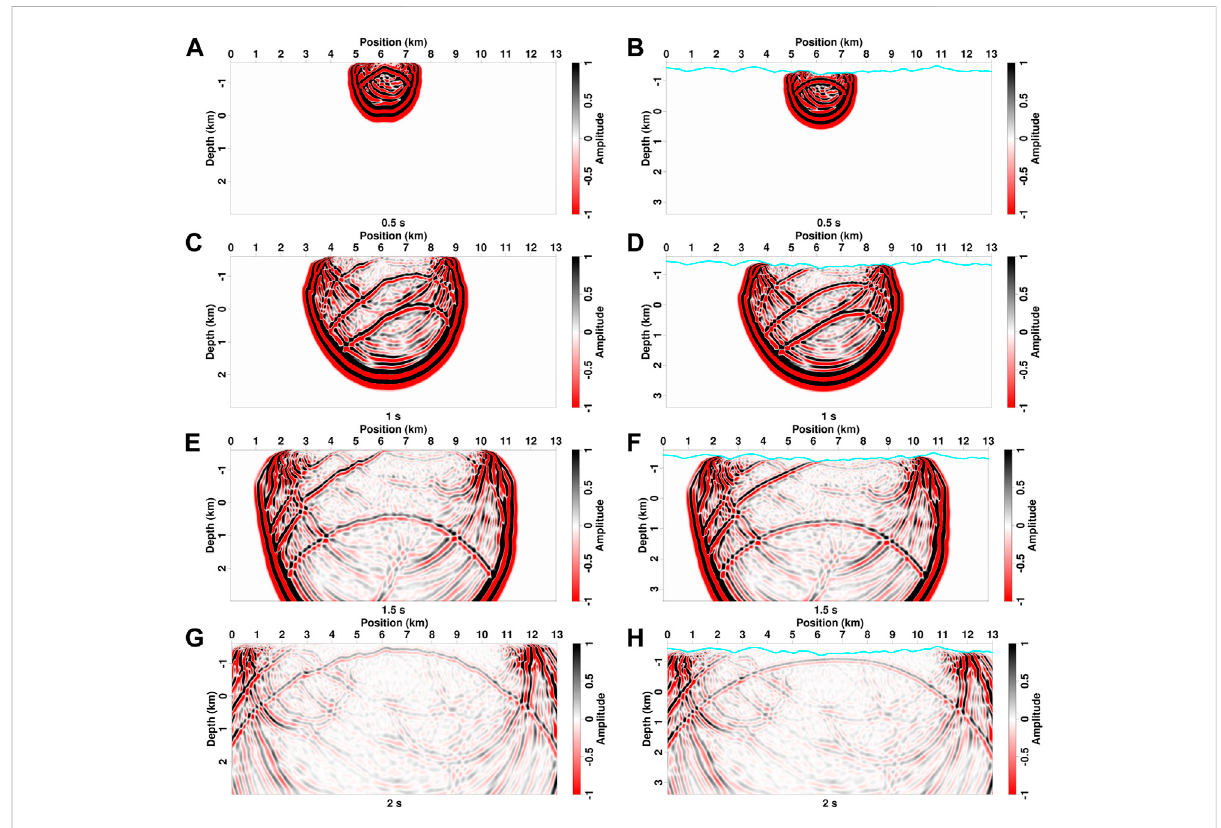
FIGURE 11 (A – H) Viscoacoustic wave fi elds of 2D Loess Plateau model at different propagation times simulated with a top absorption boundary in the computational domain (left column) and physical domain (right column). The cyan lines in panels (B,D,F, and H) denote the